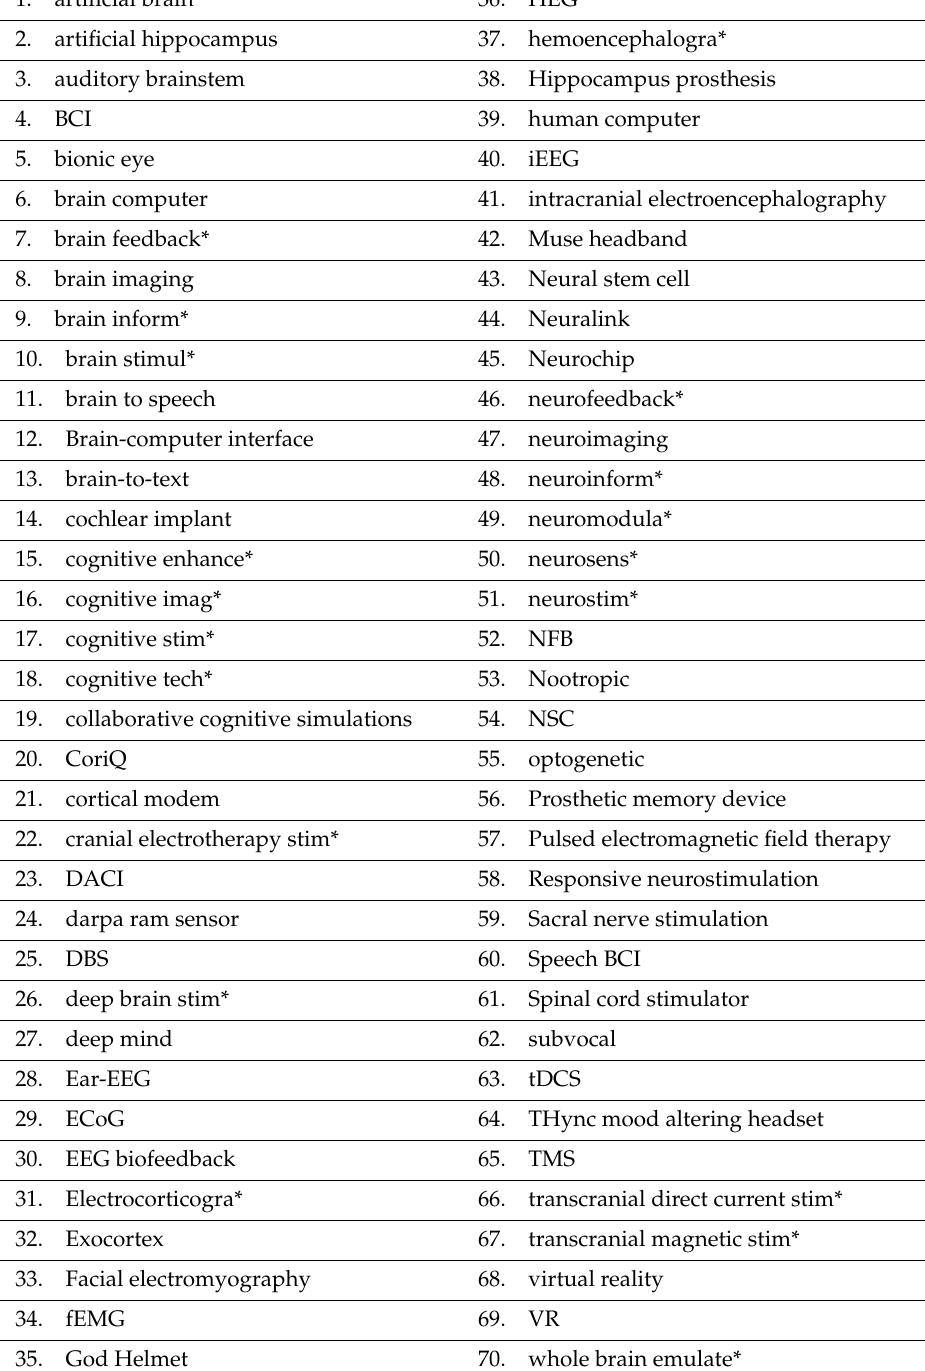
Table 1. List of neuro-advancement search